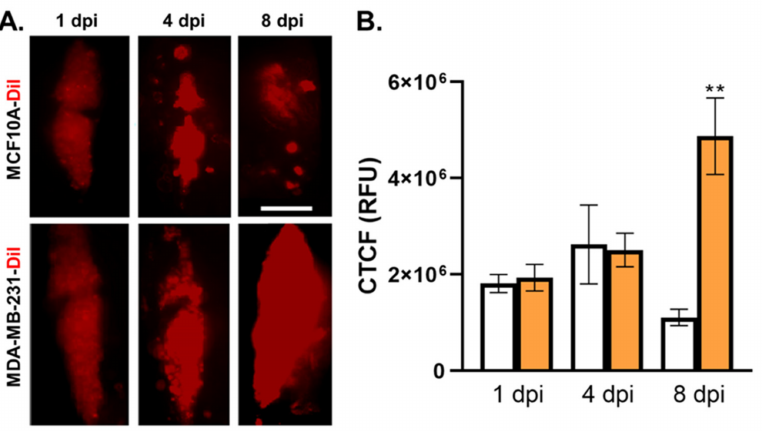
Figure 3. MDA-MB-231 TNBC cells exhibited increased tumor area in the zebrafish hindbrain ventricle compared to noncancerous breast tissue cells. ( A ). Top row: images of noncancerous breast tissue MCF10A xenograft cells treated with DiI in the hindbrain ventricle at 1, 4, and 8 dpi; bottom row: images of cancerous breast tissue MDA-MB-231 xenograft cells treated with DiI in the hindbrain ventricle at 1, 4, and 8 dpi. ( B ). Comparison of MCF10A (white columns) and MDA-MB-231 (orange columns) corrected total cell fluorescence values at 1, 4, and 8 dpi. Key: days postinjection (dpi); corrected total cell fluorescence (CTCF); relative fluorescence units (RFU); p < 0.05, “**” = 0.01; Error bars = SEM; scale bar = 100 µ m; N for MCF10A: 27 (1 dpi), 30 (4 dpi), 33 (8 dpi); N for MDA-MB-231: 27 (1 and 4 dpi), 35 (8 dpi).